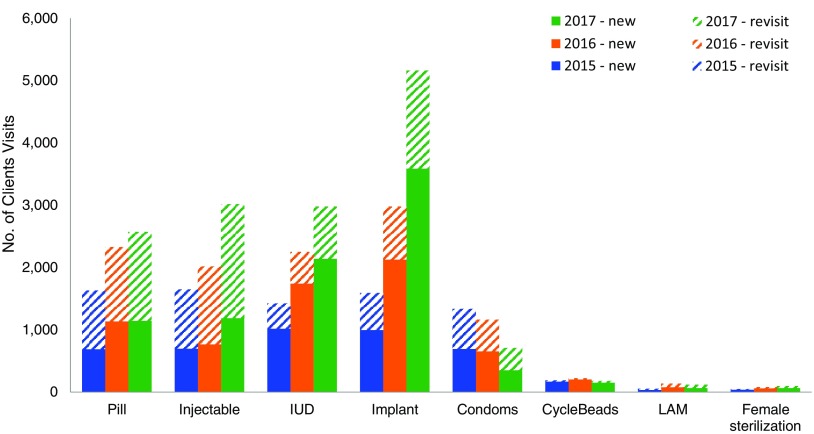
Number of Client Visits by New and Returning Visit and Family Planning Method for All 6 Health Facilities, Kenya, Phase 2Abbreviations: IUD, intrauterine device; LAM, Lactational Amenorrhea Method.